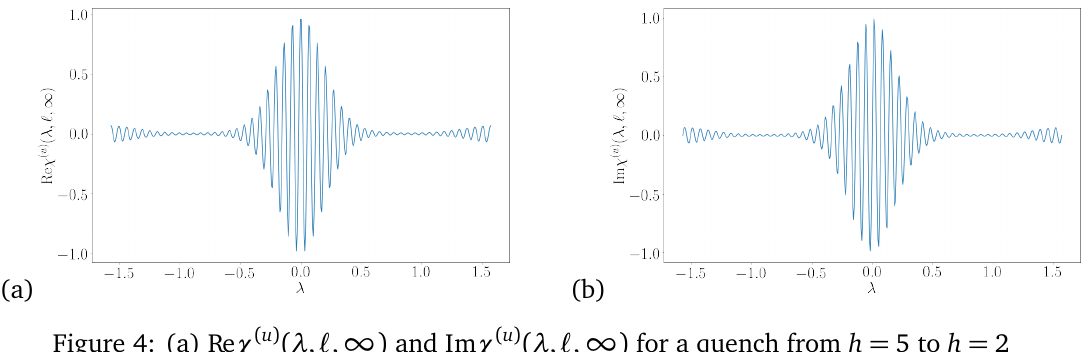
Figure 4: (a) Re χ ( u ) ( λ , (cid:96) , ∞ ) and Im χ ( u ) ( λ , (cid:96) , ∞ ) for a quench from h = 5 to h = 2 and subsystem size (cid:96) =